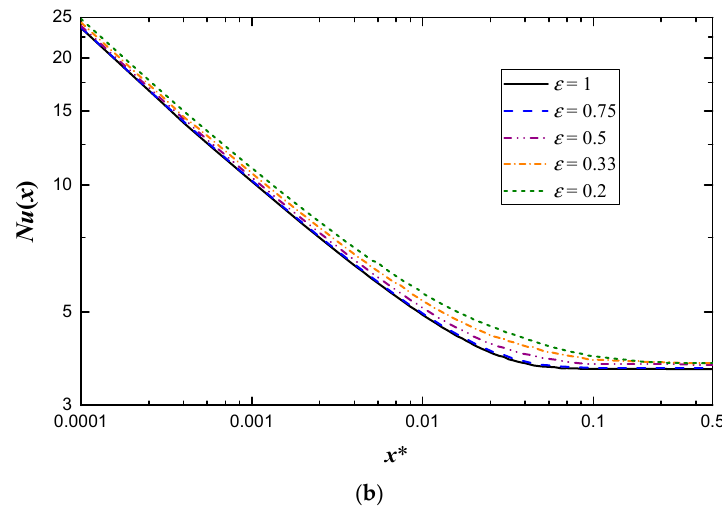
Figure 6. Local Nusselt number variation along length of channel with different aspect ratios at ( a ) Re = 50; ( b ) Re = 1000.